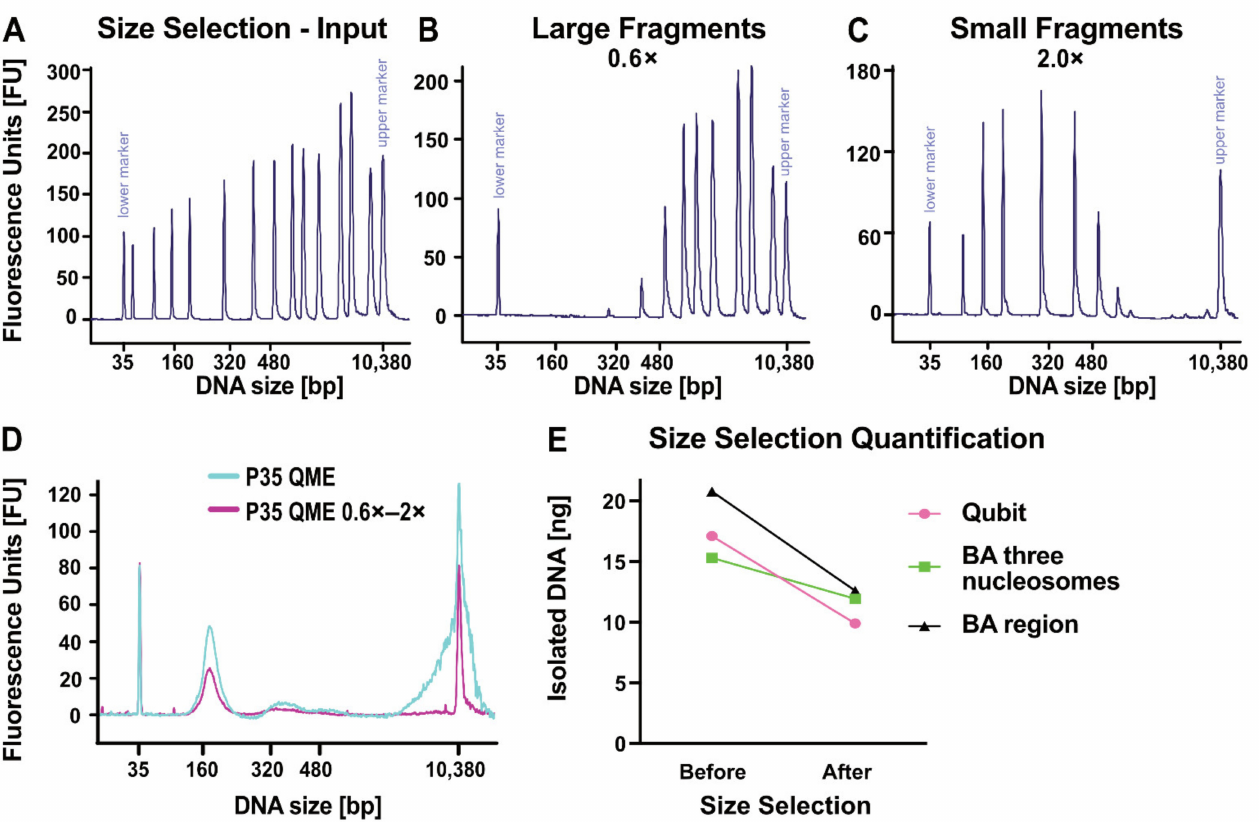
Figure 5. Size selection strategies for specific enrichment of cell-free DNA. ( A ) Bioanalyzer (BA) profile of DNA HS ladder with defined peak sizes serving as input for size selection. ( B ) DNA ladder from (A) after performing right side size selection. 0.6 × bead bound eluate loaded. ( C ) DNA ladder from (A), with small DNA being in the 0.6 × supernatant. Small fragments were bound in a second step by a 2.0 × bead ratio and subsequently eluted. ( D ) cfDNA of P35 isolated with QIAamp MinElute ccfDNA Mini Kit (QME) was subjected to size selection. DNA profile before (light blue) and after size selection (pink) employing the 0.6x bead ratio to separate cfDNA from larger DNA fragments. ( E ) Quantification of total DNA (pink) by Qubit measurement and of cfDNA peaks (160–480 bp, light green) and total DNA (region 50–7000 bp, black) by BA measurement before and after size